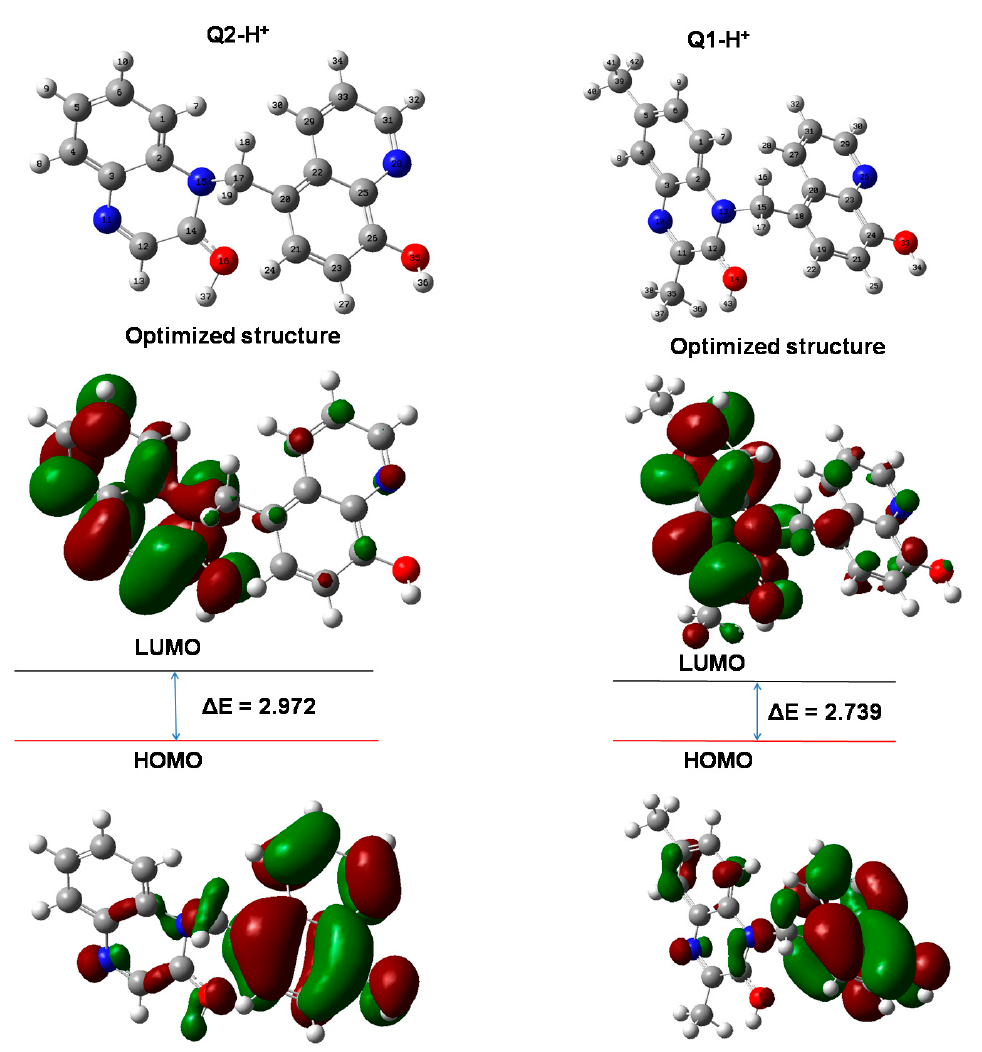
Figure 7. Optimized molecular structure, HOMO and LUMO of Q1 and Q2 in their protonated forms using DFT/B3LYP/6-31+G (d,p) in aqueous solution. Table 5. Calculated quantum chemical indices of the studied compounds in their neutral and protonated states.